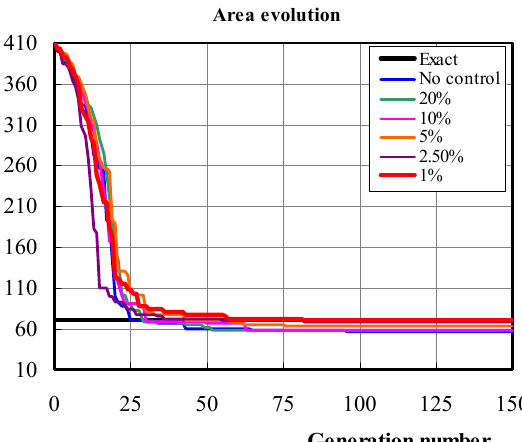
Fig. 3. Influence of γ over the evolution of the objective